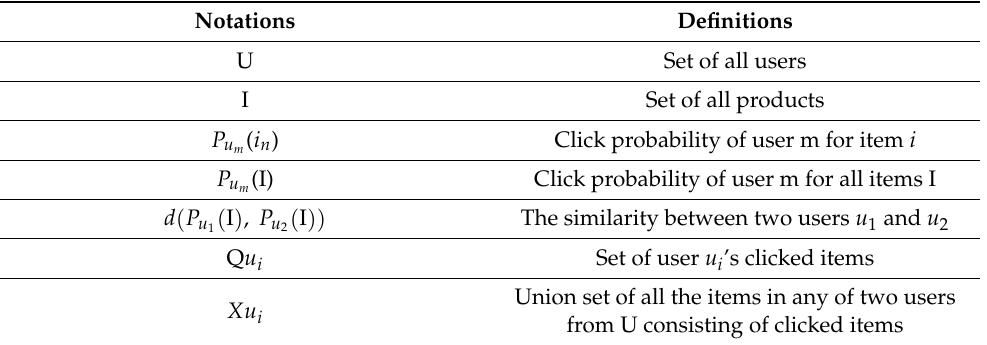
Table 1. Different notation used with its respective